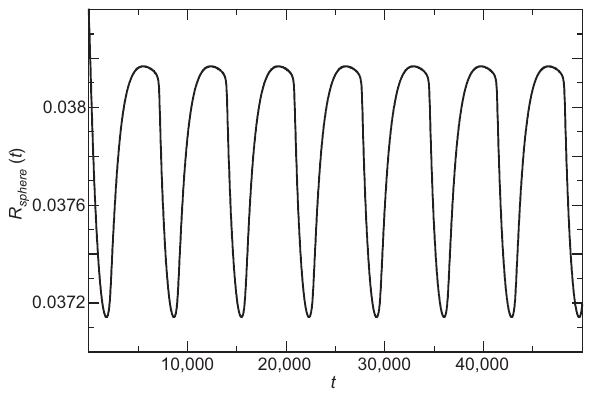
( t ) for D = 1 × 10 -7 cm 2 / s . sphere perm